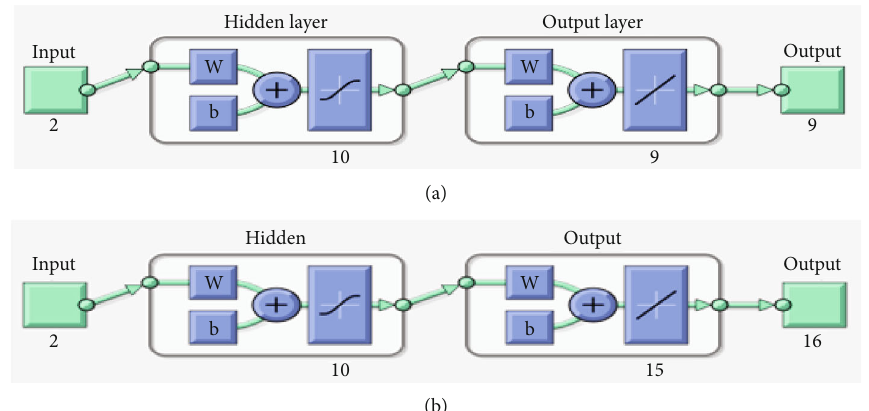
Figure 8: Structure of ANN for PVE under (a) uniformly irradiated (b) partially shaded